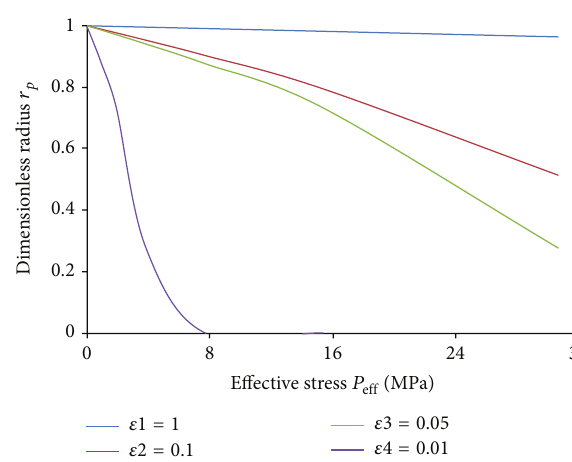
Figure 5: Effect of aspect ratio on taper